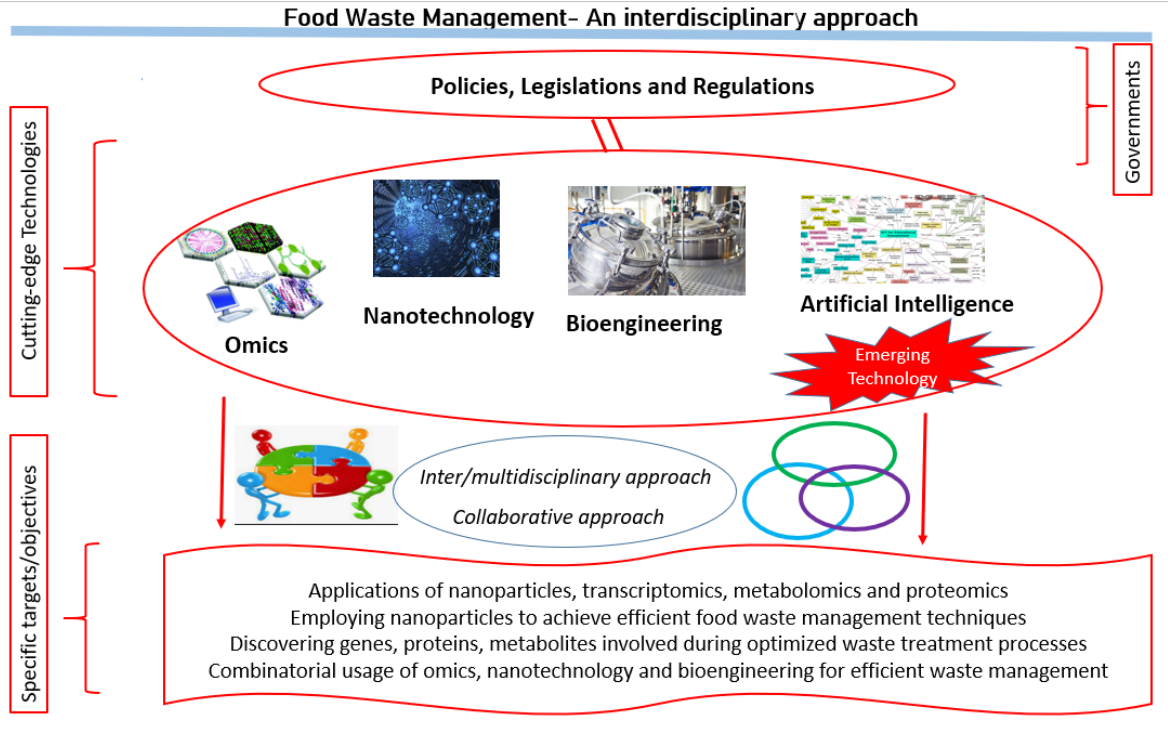
Figure 4. A network for food waste management with a multidisciplinary approach.